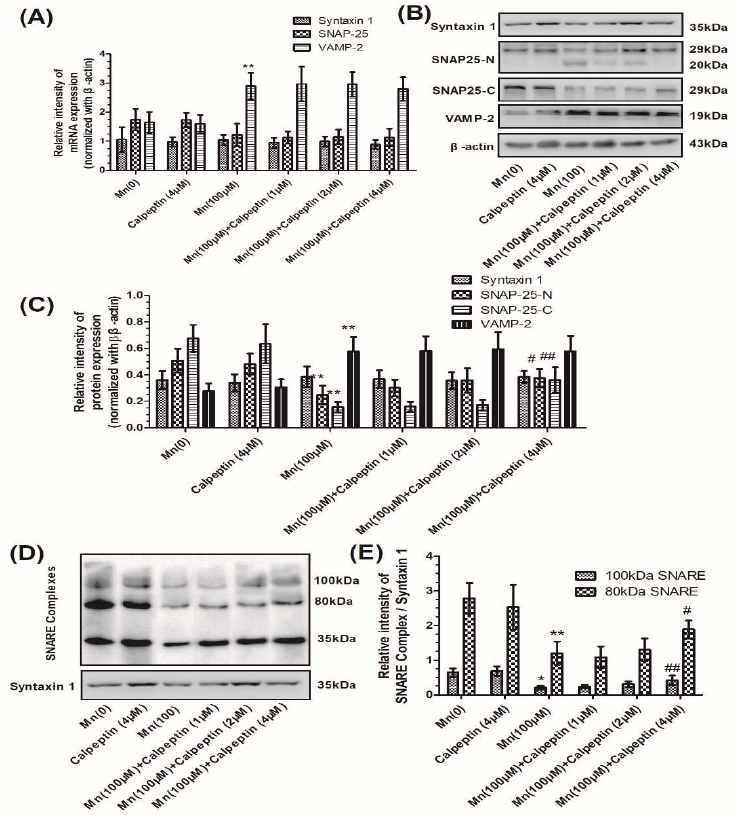
Figure 3. Calpeptin ameliorated SNAP-25 cleavage and promoted the formation of the SNARE complex. ( A ) The mRNA expression of syntaxin 1, SNAP-25, and VAMP-2 normalized with β -actin. ( B ) The protein products of syntaxin 1, N-terminal of SNAP-25, and C-terminal of SNAP-25, VAMP-2, and β -actin. ( C ) Semi-quantitative analysis of the protein expression of syntaxin 1, N-terminal of SNAP-25, and C-terminal of SNAP-25 and VAMP-2, normalized with β -actin. ( D ) The protein products of the SNARE complex. ( E ) Semi-quantitative analysis of the protein expression of SNARE complex protein normalized with syntaxin 1 protein. Data represent mean ± standard deviation, n = 4. * p < 0.05 and ** p < 0.01 indicate significant differences from controls; # p < 0.01 and ## p < 0.01 indicate significant differences from the 100 µ M Mn-treated